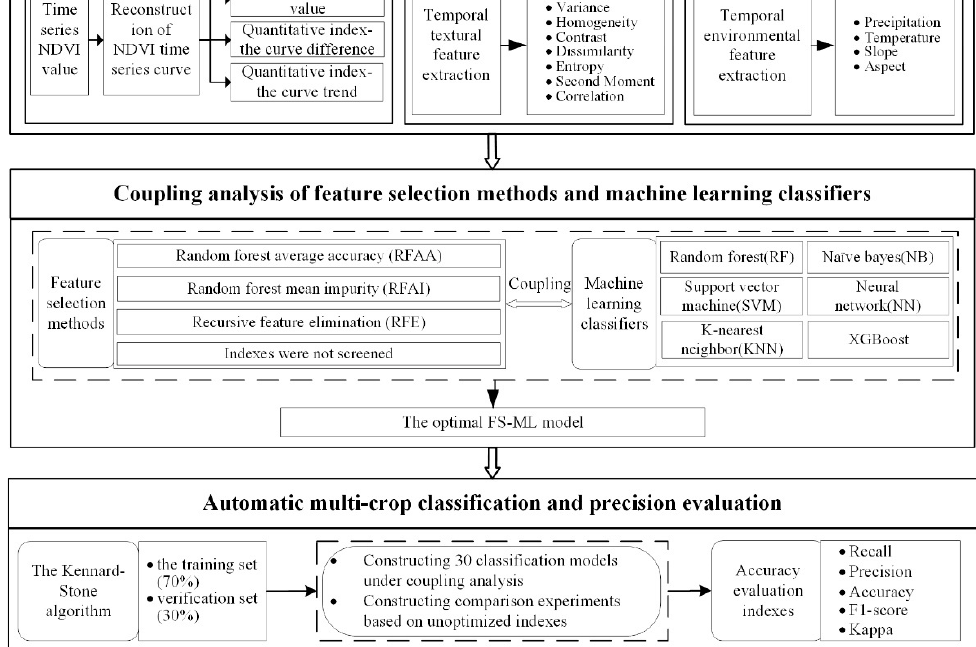
Figure 4. General workflow of this